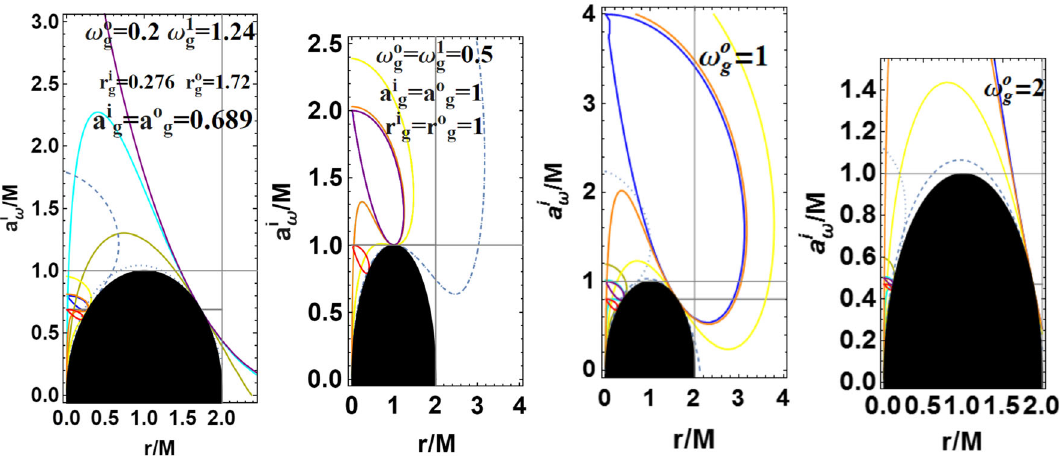
Fig. 10 Horizon construction: metric bundles Γ a is a BH on the extended plane. Purple and blue curves are for σ = 1; with equal tangent g orange and cyan curves are for σ = 0 . 97, darker-yellow and yellow spin a g and tangent frequencies ω g = ω b and, consequently, equal tan- curves are for σ = 0 . 7, dotted and dashed curves are for σ = 0 . 2, and gent radius r g . Construction of horizons r + = r o g and r − = r i g for a the red curve is for σ = 1. It follows from the discussion of Eqs. (30, spacetime with a = a g through the corresponding bundle a 1 g = a 2 g is 33, 35, 36, 38) also shown as the metric bundles with origin a i g = a 0 . The black region